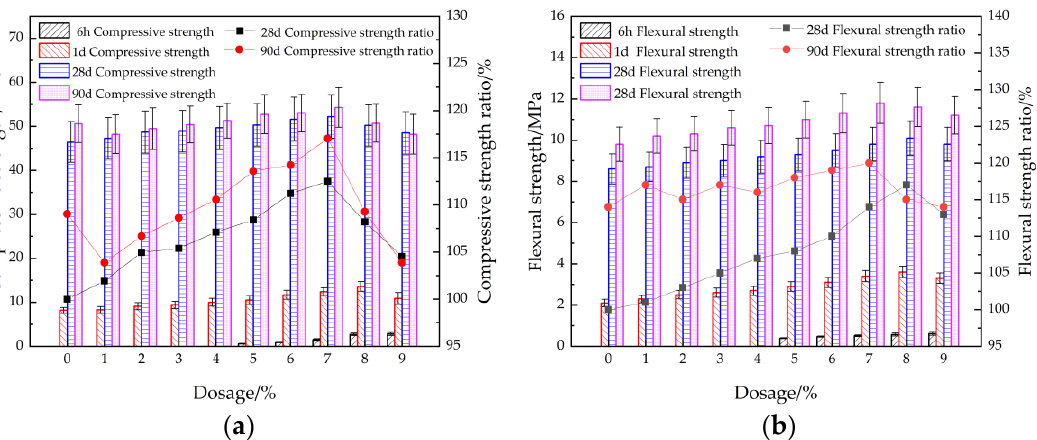
Figure 3. The mechanical strengths of cement mortar with accelerator. ( a ) Compressive strength, ( b ) flexural strength.